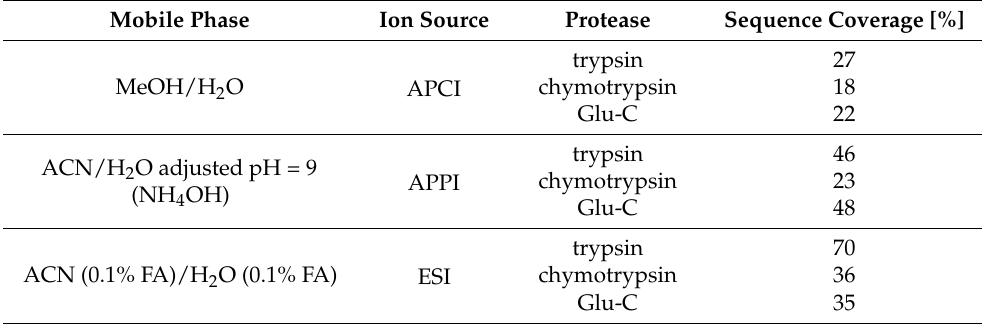
Table 3. BSA sequence coverage values for tryptic, chymotryptic, and Glu-C digests (10 µ L injected; c = 0.65 mmol · L − 1 ) analyzed by APCI, APPI, or ESI using optimized mobile phases. The peptides were separated at 60 ◦ C by a 25-min gradient elution; the mobile phase flow rate was 250 µ L · min − 1 . Data were evaluated using Amanda and Sequest